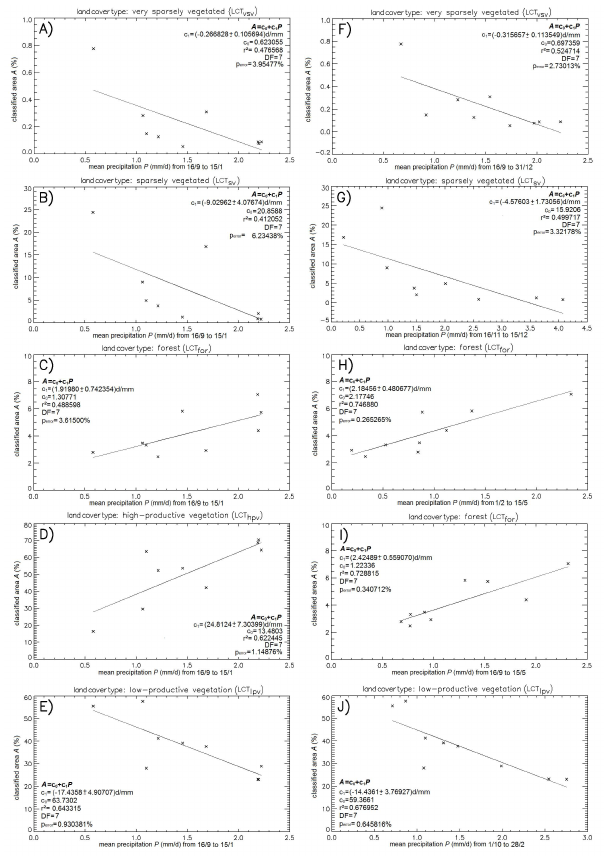
Fig. 14. Correlations of mean daily precipitation (MP) and classi- fied area of each land cover type. Best fit for a common time period from 16 September to 15 January(A–E) and best individual fit for each land cover type (F–J) including second best individual fit for land cover type forest (I). DF = Degrees of